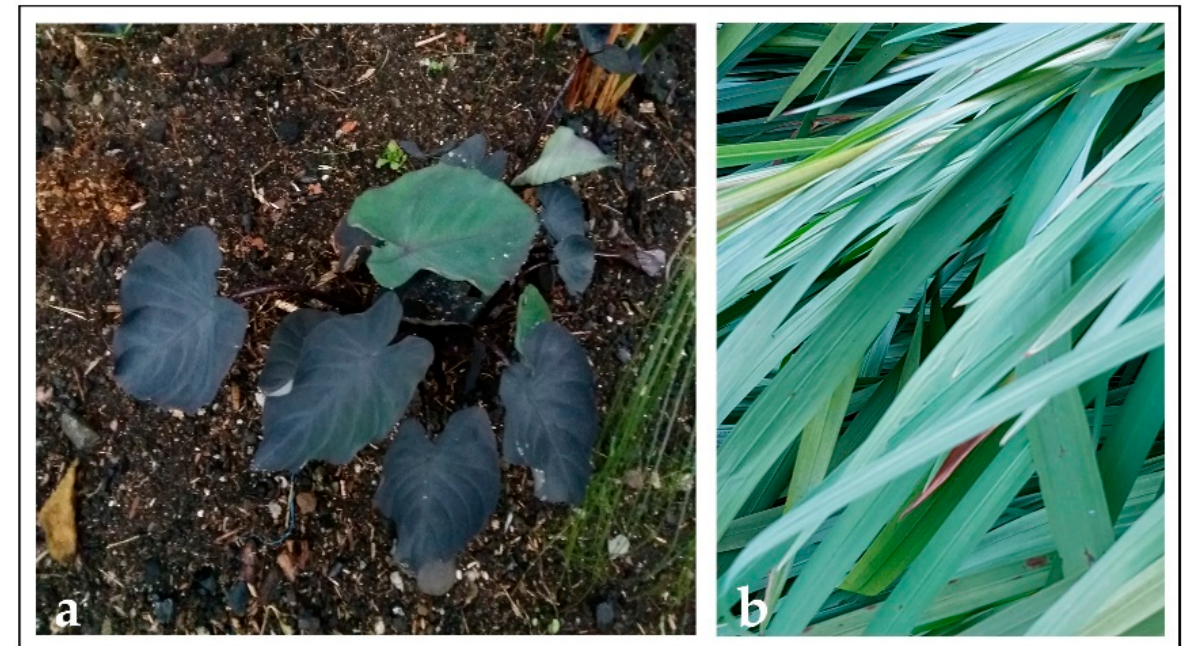
Figure 2. Leaves from ( a ) black taro ( Colocasia esculenta ) and ( b ) Montbretia ( Crocosmia aurea ).